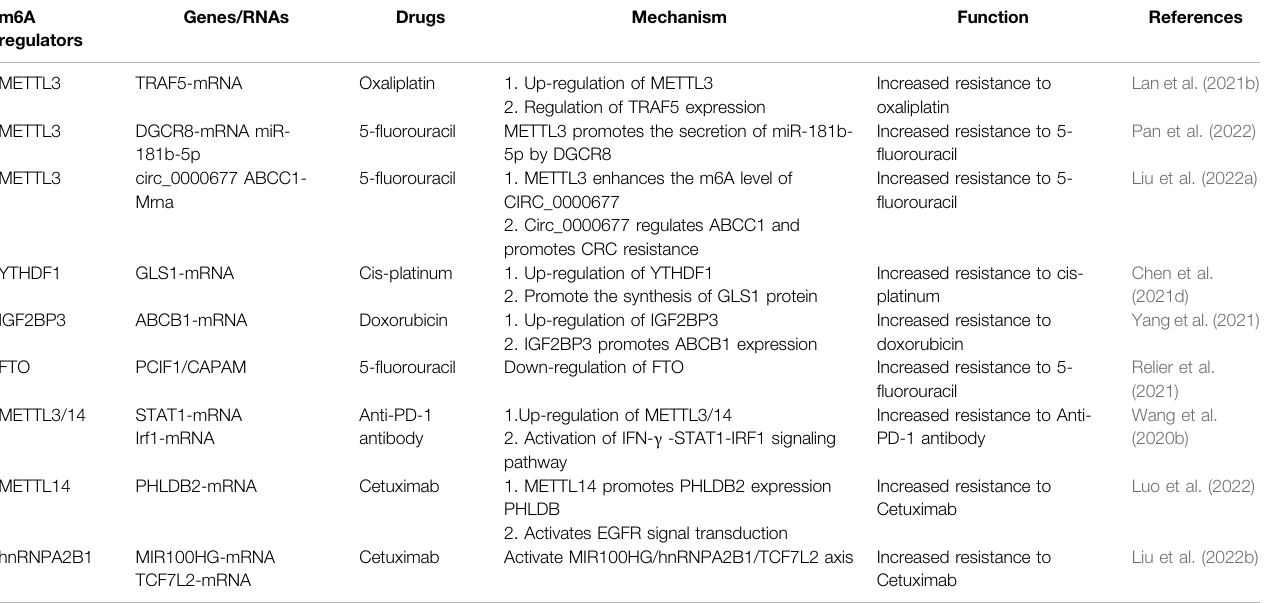
TABLE 3 | The roles of different m6A regulators in colorectal